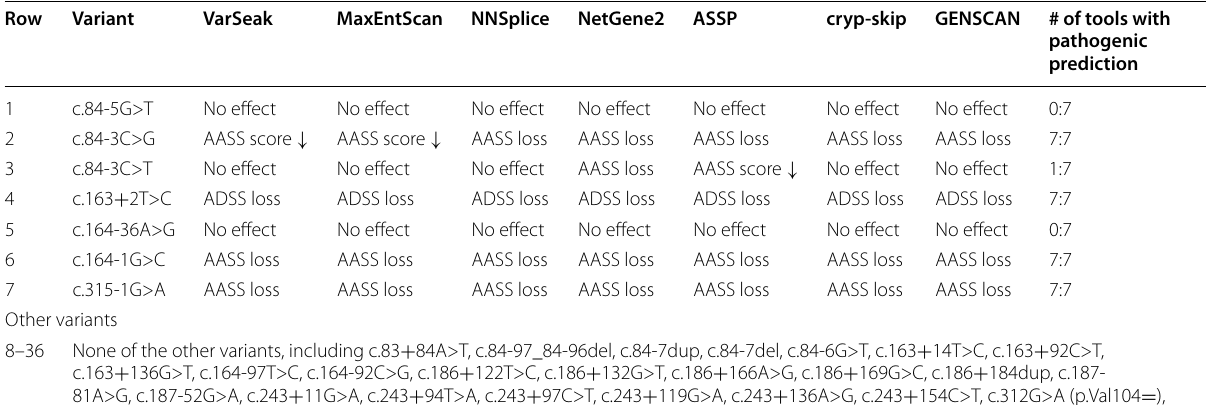
Table 3 Pathogenicity prediction of PTS gene intronic and synonymous variants. AASS: authentic acceptor splice site, ADSS: authentic donor splice